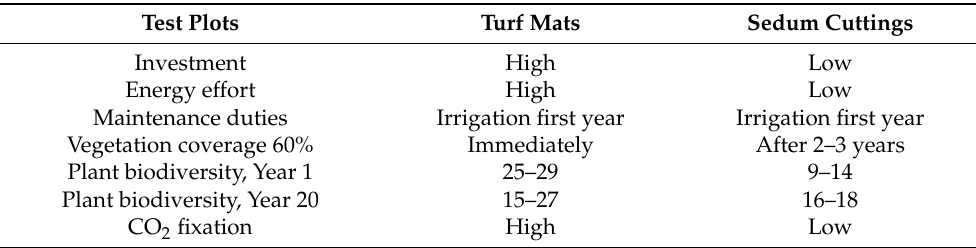
Table 19. Turf mat benefits compared to sedum cuttings as the primary vegetation cover, with results from this